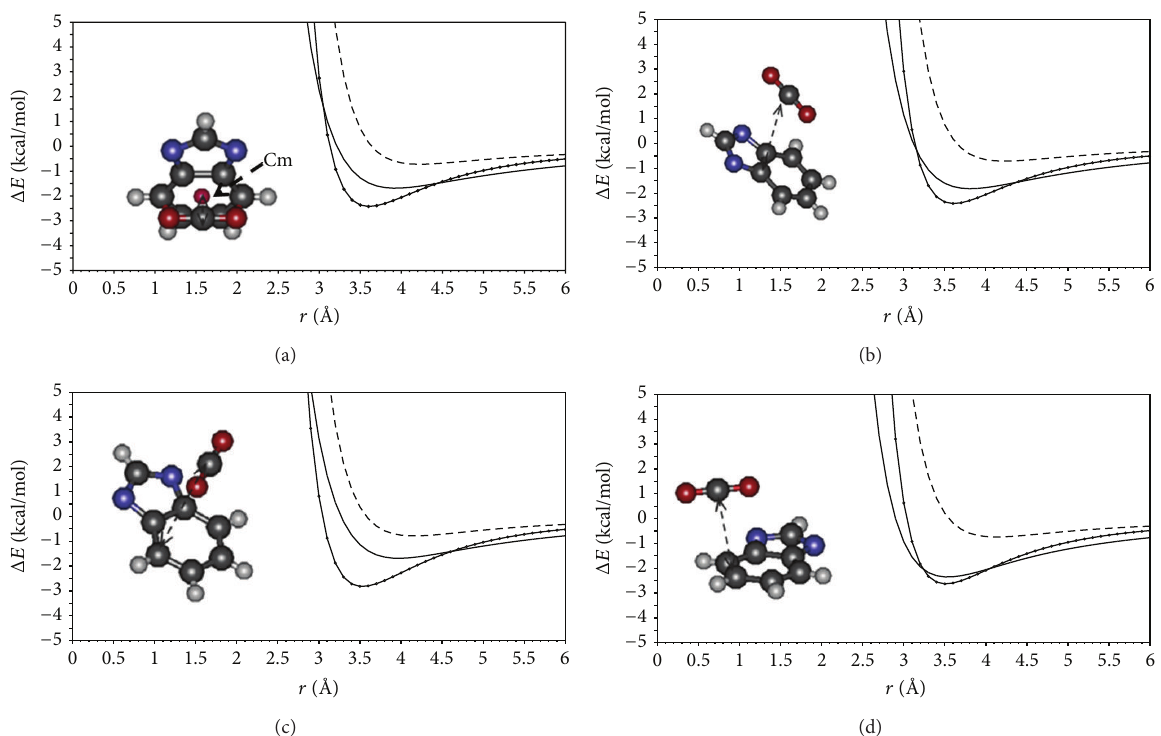
Figure 4: The comparison between Δ𝐸 𝐶𝐶 (–), Δ𝐸